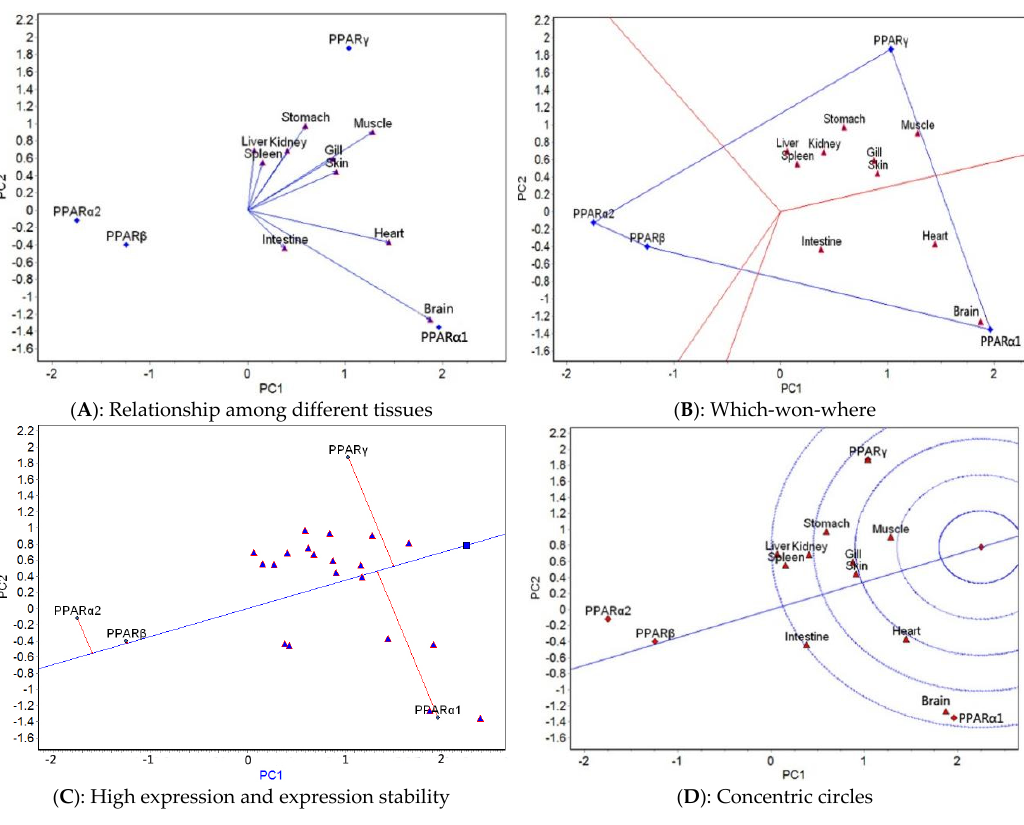
Figure 6. GGE biplots of PPAR genes in different tissues at 25 °C.